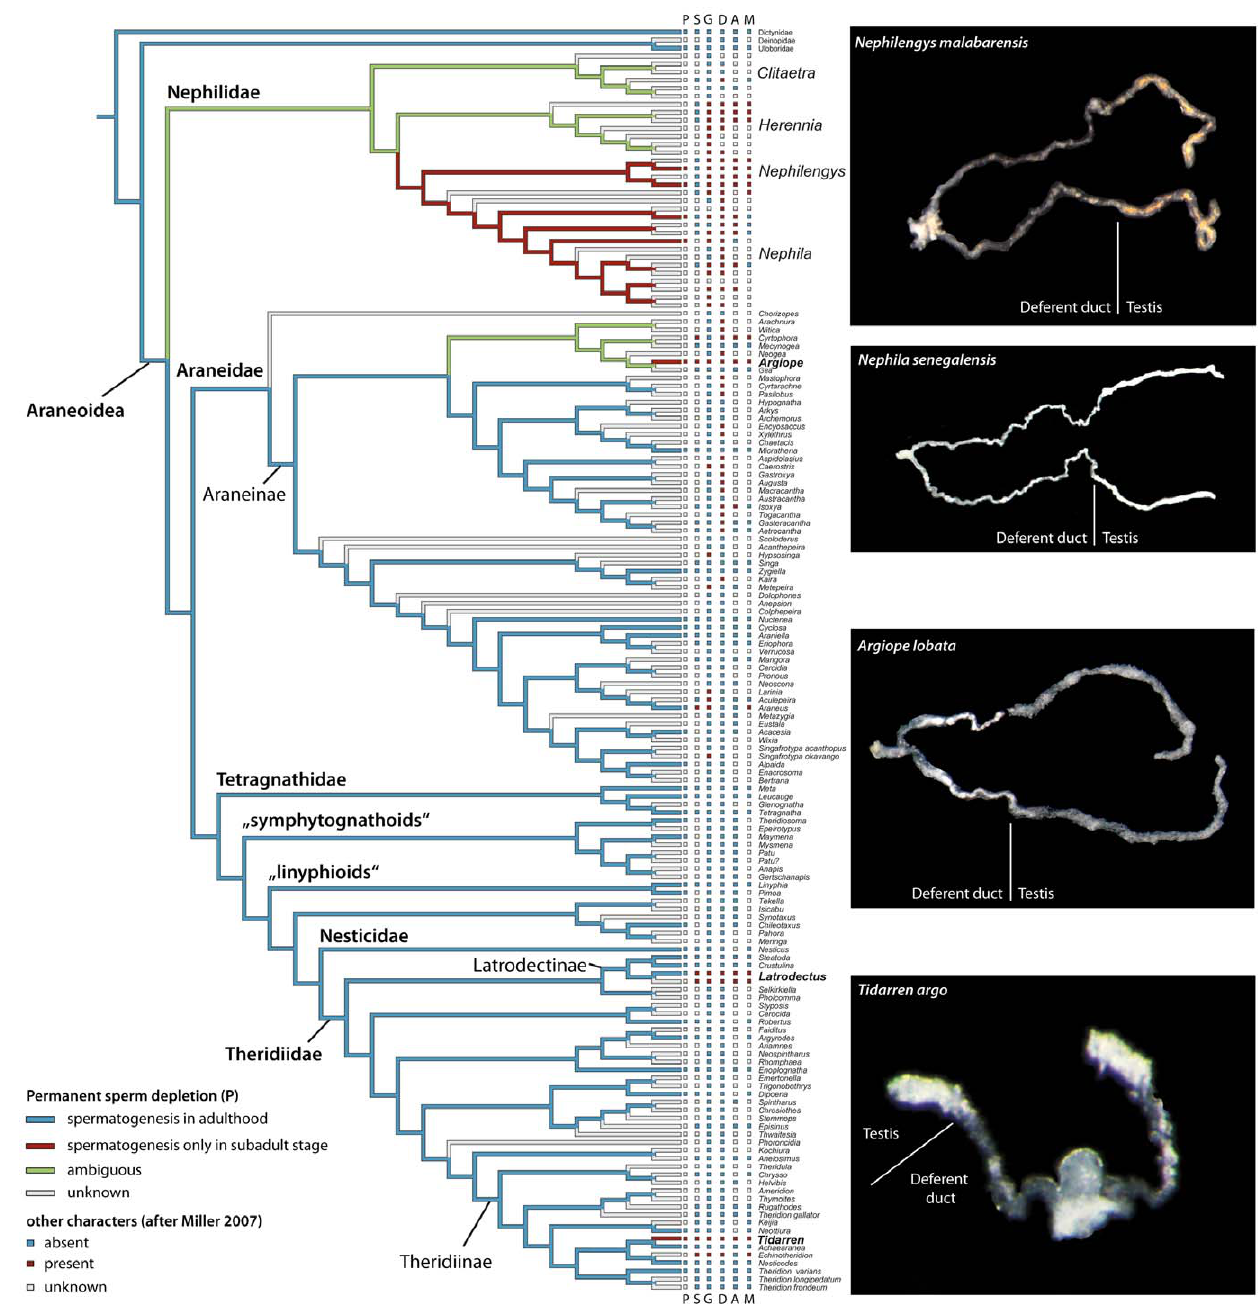
Figure 5. Evolution of PSD in araneoid spiders. PSD is optimized on the phylogeny of Araneoidea according to Miller [21] (topology ‘‘Kuntner et al. ((TA)(EN))’’, Fig. 1 and supplemental material). Note the ambiguous optimization in the Nephilidae node and within Araneidae. Boxes indicate states of following characters: permanent sperm depletion ( P ), male sacrifice behavior ( S ), male genitalia mutilated in the course of copulation ( G ), extreme sexual size dimorphism ( D ), male accumulation ( A ), and male monogamy ( M ). The pictures in the right column show examples from all genera where PSD is present indicated by the equal diameter of deferent ducts and testes in adult male reproductive system ( Tidarren argo taken from